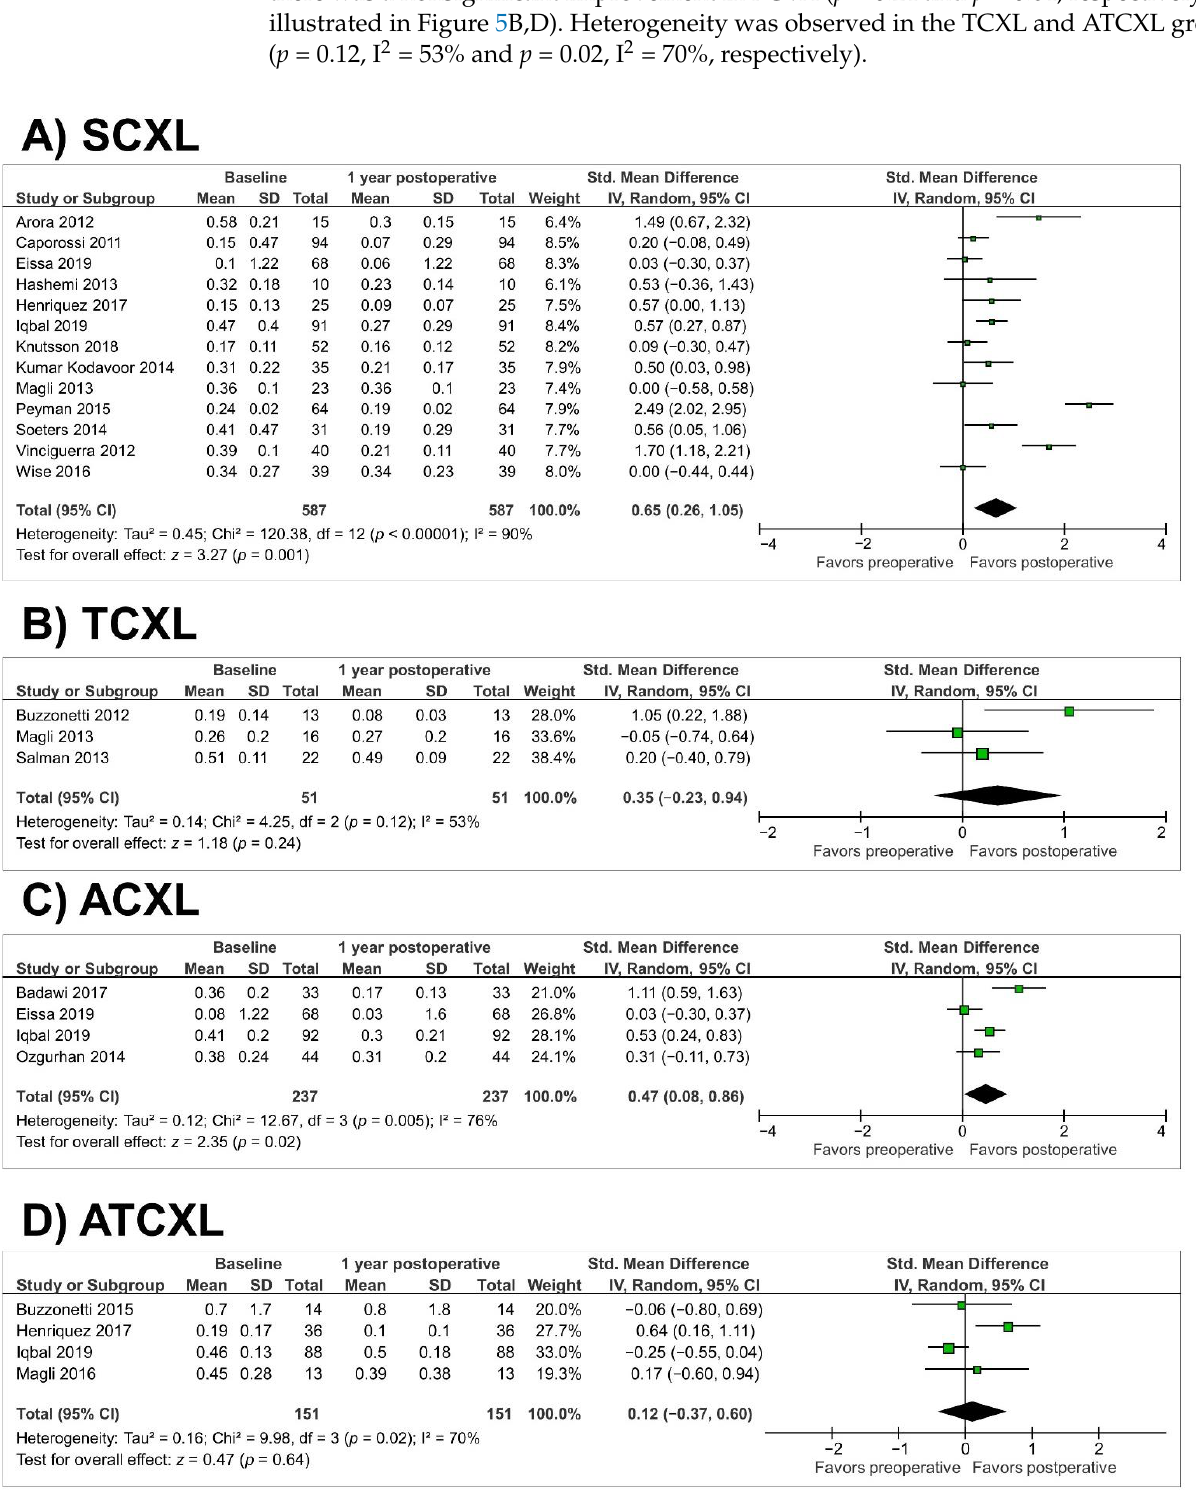
Figure 5. Forest plot of best-corrected visual acuity 1-year standardized mean differences in logMAR in studies included in meta-analysis. ( A ), standard cross-linking (SCXL); ( B ), accelerated CXL (ACXL); ( C ), transepithelial CXL (TCXL); ( D ), accelerated and transepithelial CXL (ATCXL). IV = inverse variance, CI = confidence interval, Tau 2 = tau-square statistic, Chi 2 = chi-square statistic, df = degrees of freedom, I 2 = I-square heterogeneity statistic, z = Z-statistic.